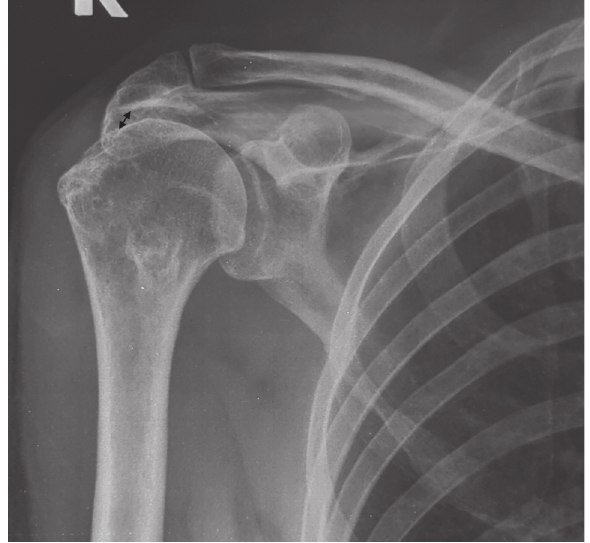
Anteroposterior radiographs showing a shoulder Fig. 2: without radiographic signs of loosening after 10 months. No radiolucency is seen around the screws